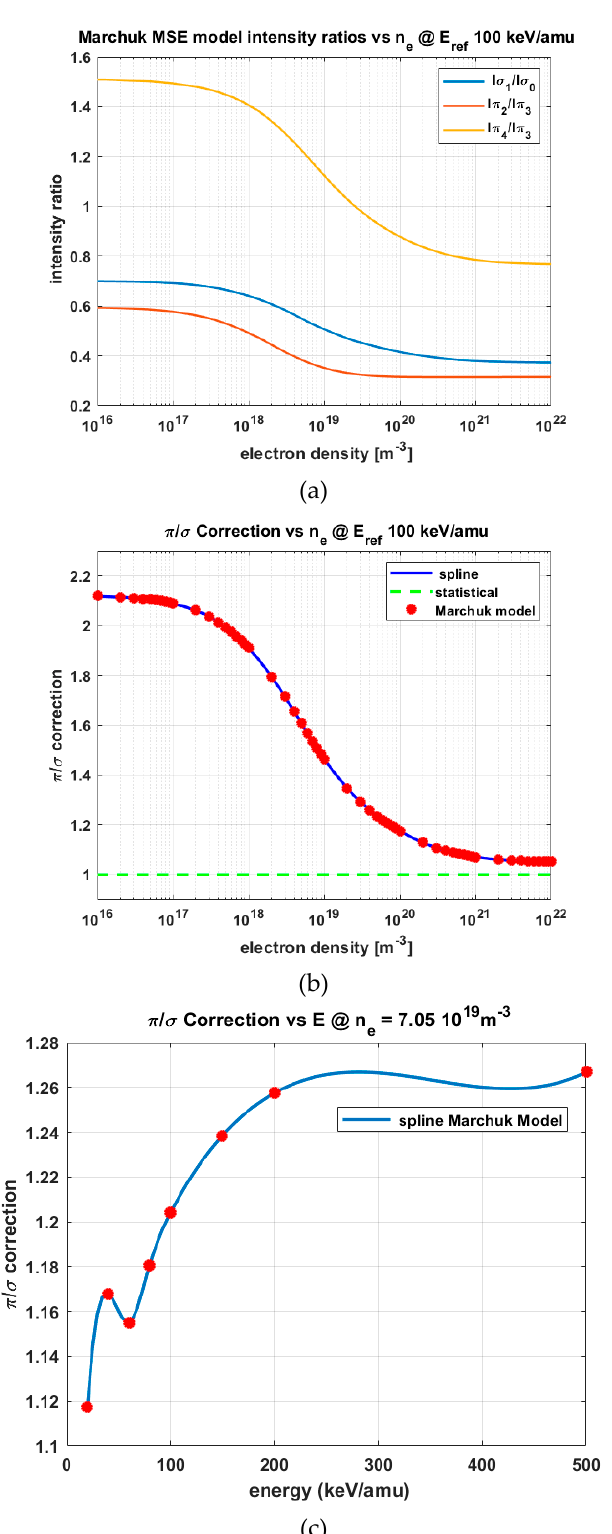
Figure 7. ( a ) Collisional model for Motional Stark Effect (MSE) multiplet line ratios. E beam 100 keV/amu; ( b ) collisional model for MSE multiplet: Ratio of π / σ net emission and its deviation from statistical population versus density; ( c ) collisional model for MSE multiplet showing the ratio between π to σ emission and its deviation from statistical population versus energy. n e = 7.2 · 10 19 m − 3 , T i = T e = 20 keV.